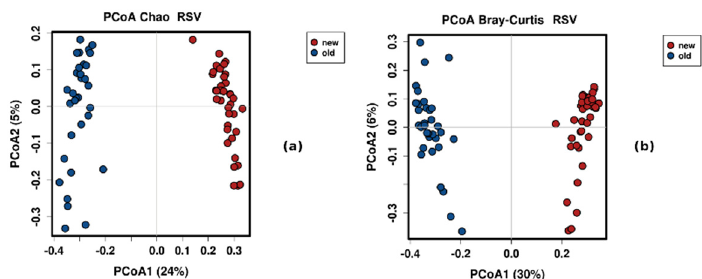
Figure 3. Beta diversity principal coordinates analysis (PCoA) plots were created for ( a ) Chao and ( b ) Bray–Curtis comparing the current study (red) with our previous study (blue). Samples were rarefied to 6600 sequence reads.